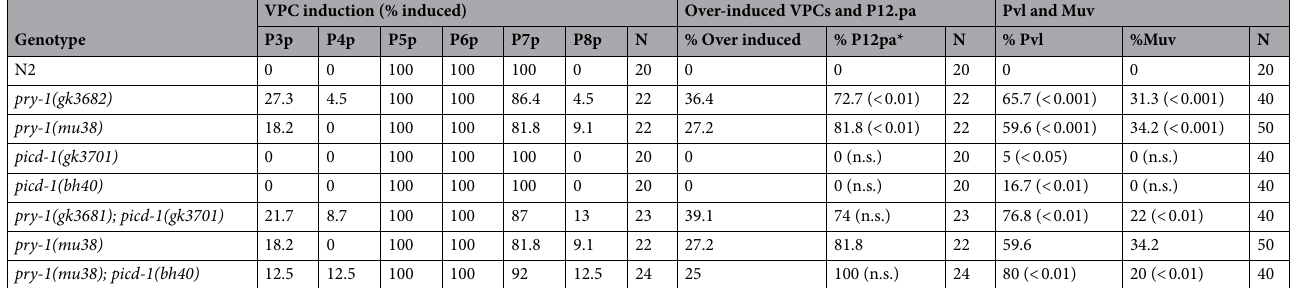
Table 1. Analysis of VPC induction, P12.pa cell fate, Pvl, and Muv penetrance in different strains. Each data consists of two independent replicates. Statistical analyses were done using one way-ANOVA. p values are indicated in brackets. n.s., not significant. While pry-1 and picd-1 mutants were compared to N2 control, pry-1; picd-1 double mutants were compared to respective pry-1 alleles. *Extra P12.pa cell in the place of P11.p. N number of animals